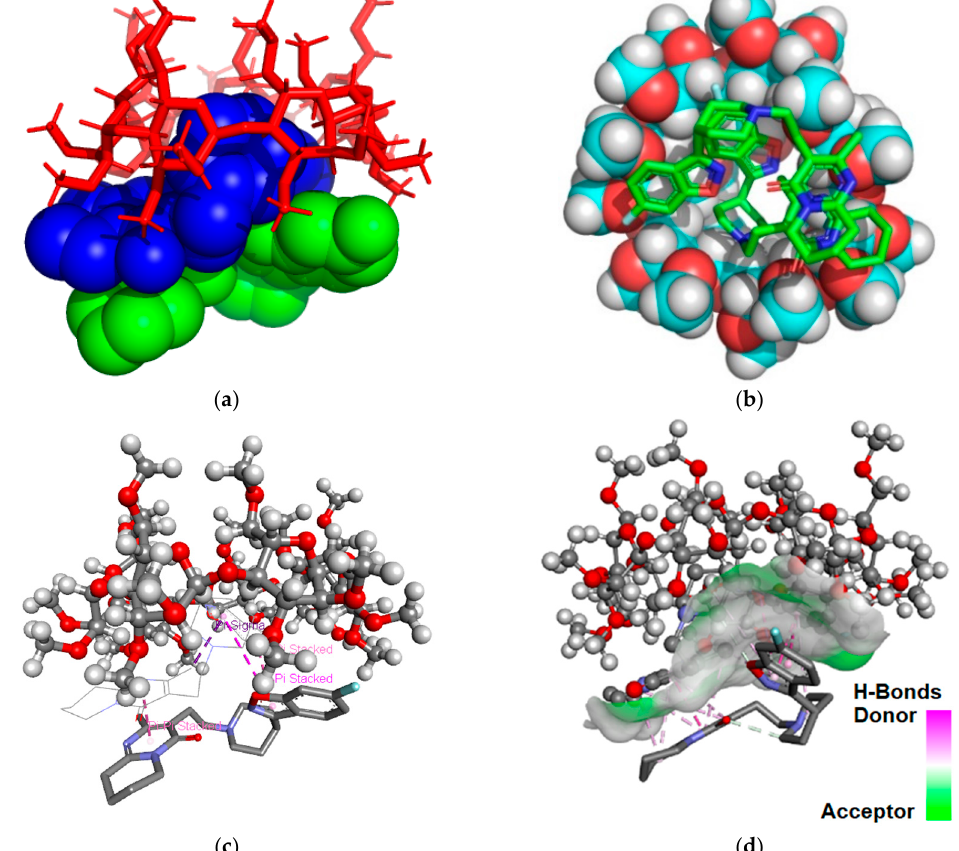
Figure 4. Molecular docking results revealing the geometry of inclusion complex for 2:1 molar ratio between RSP and TM- β -CD. Guest substance is presented in spheres green and blue ( a ), in sticks colored by element ( b ) and host TM- β -CD, in red sticks ( a ), in sphere colored by element ( b ); image ( c ) shows contacts between RSP colored by element and TM- β -CD, in ball and sticks; image ( d ) shows H-bond surface interaction between RSP and TM- β -CD.